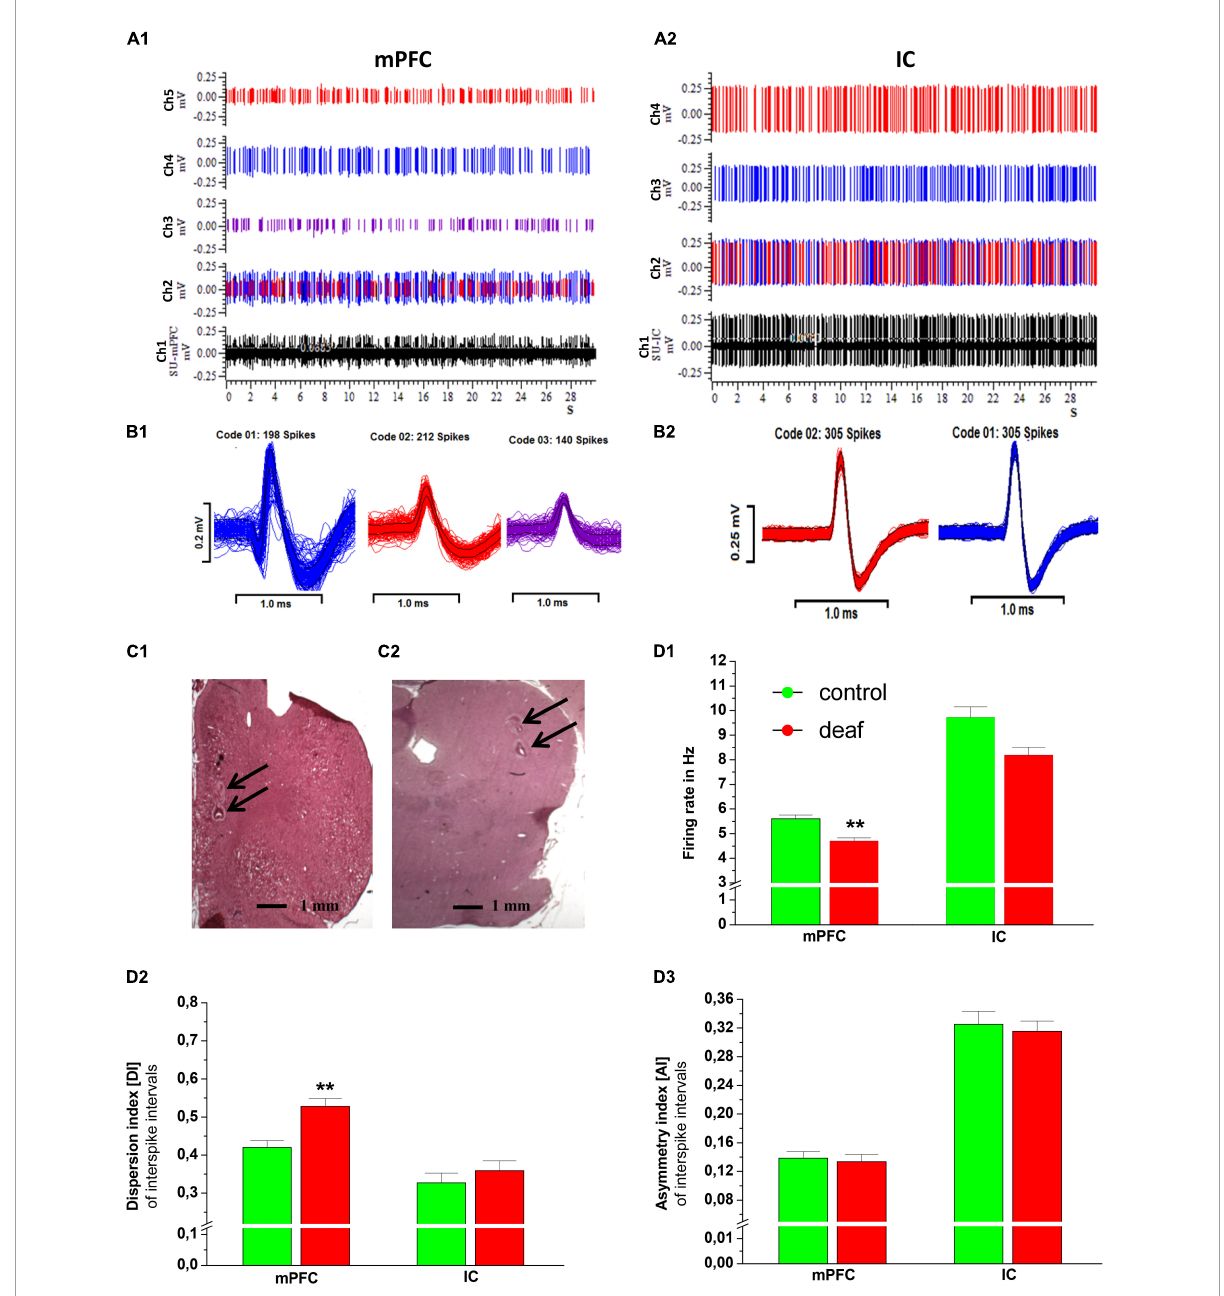
FIGURE3 An example of 30 s recording epochs of the extracellular neuronal raw spikes from mPFC and IC are shown in panel (A) (channel 1 in black color). Channel 2 shows the raster plots with all different types of neuronal single units identified by spike sorting. Additionally, individual spikes of single units recorded in mPFC are shown in panel (A1) (channels 3, 4, and 5) and from IC in panel (A2) (channels 3 and 4). Corresponding action potential waveform of the mPFC and of the IC are shown in panels (B1,B2) . Representative examples of HE stained recording areas with electrical lesions (arrows) in coronal sections of the mPFC (RC from Bregma + 2 . 7 ; C1 ) and IC (RC from Bregma − 8 . 7 ; C2 ). Firing rate (D1) , dispersion index (D2) , and asymmetry index (D3) for deaf and controls are shown as mean ± S.E.M. Differences between deaf rats and controls are shown as asterisks (* P < 0.05 after